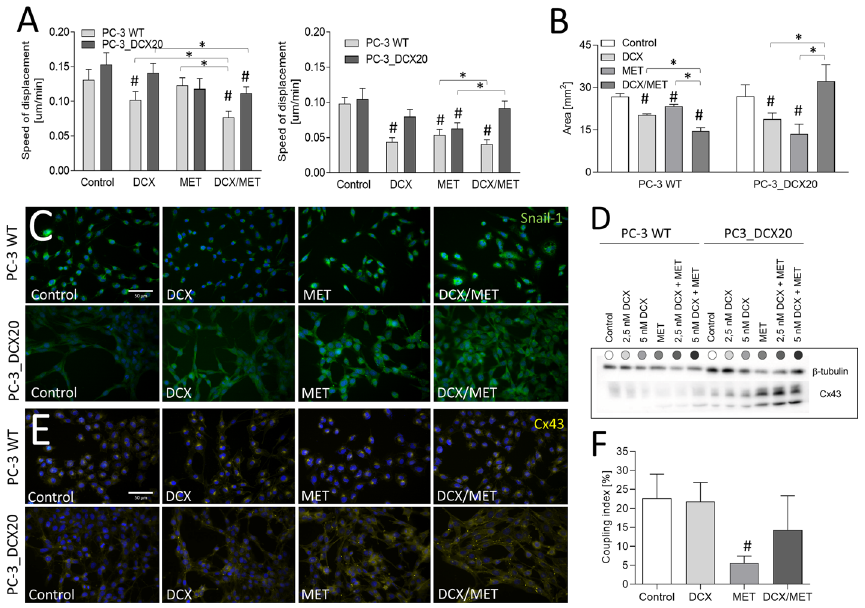
Fig. 6 Combined DCX/MET treatment enhances invasive potential of DCX‑resistant PC‑3 cells. A Displacement of PC‑3 WT and DCX‑resistant PC‑3_DCX20 cells was estimated with time‑lapse videomicroscopy immediately after the administration of DCX (2.5 nM) and/or MET (10 mM; cf. Additional file 1: Figs. S1 and S4, left panel) or after 48‑h‑long treatment (right panel). B Invasiveness of DCX and/or MET treated cells estimated with Transwell migration assay. C Snail‑1 expression and localization in PC‑3 WT/ PC‑3_DCX20 cells cultivated in the presence of (2.5 nM) and/or MET (10 mM) [Snail‑1 (green), DNA (blue)]. D , E Cx43 levels and intracellular localization in DCX‑ and/or MET‑treated cells estimated with immunoblotting ( D , β‑tubulin was used as a reference protein) and immunofluorescence ( E ; Cx43: yellow, DNA: blue). F GJIC estimated with calcein transfer assay in the absence/presence of AGA (α‑glycyrrhetinic acid; 25 μM). Coupling index/ratio represents the percentage of coupled donor cells. The statistical significance of the differences was tested with Student’s t ‑test; # P 0.05 versus untreated control; * P 0.05 as indicated in the charts. All ≤ ≤ results are representative of at least three independent experiments ( N 3). Error bars represent SEM. Note ≥ increased invasiveness of Snail‑1/Cx43 high cells after